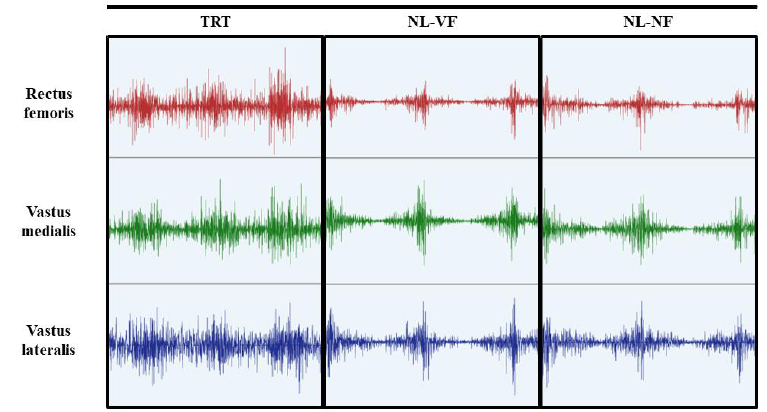
Figure 2. Illustration of electromyographic signal record. TRT, traditional resistance training, NL-VF, no load with visual feedback; NL-NF, no load with no feedback.